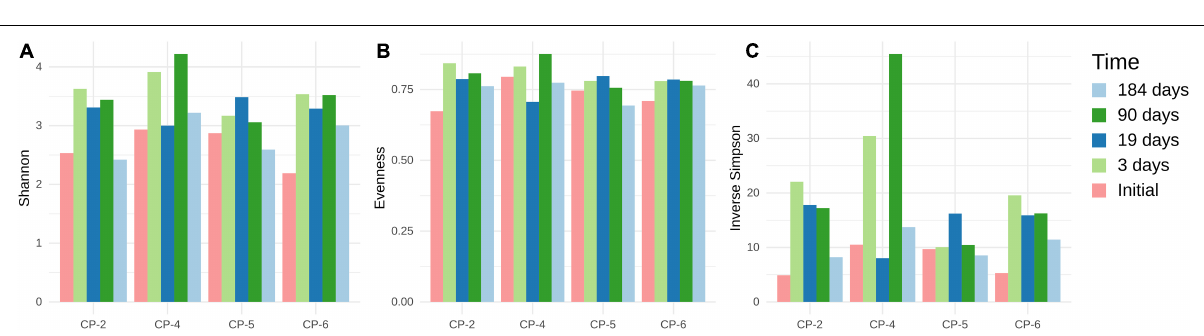
FIGURE 7 | Non-metric Multidimensional Scaling (NMDS) ordination plot of Bray-Curtis community dissimilarities based on bacterial ARISA profiles with added ordination for environmental variables: Fe(II) concentration in µ gL − 1 ; total iron content in mgL − 1 ; redox potential (ROP) and pH. Axes represent arbitrary distance.